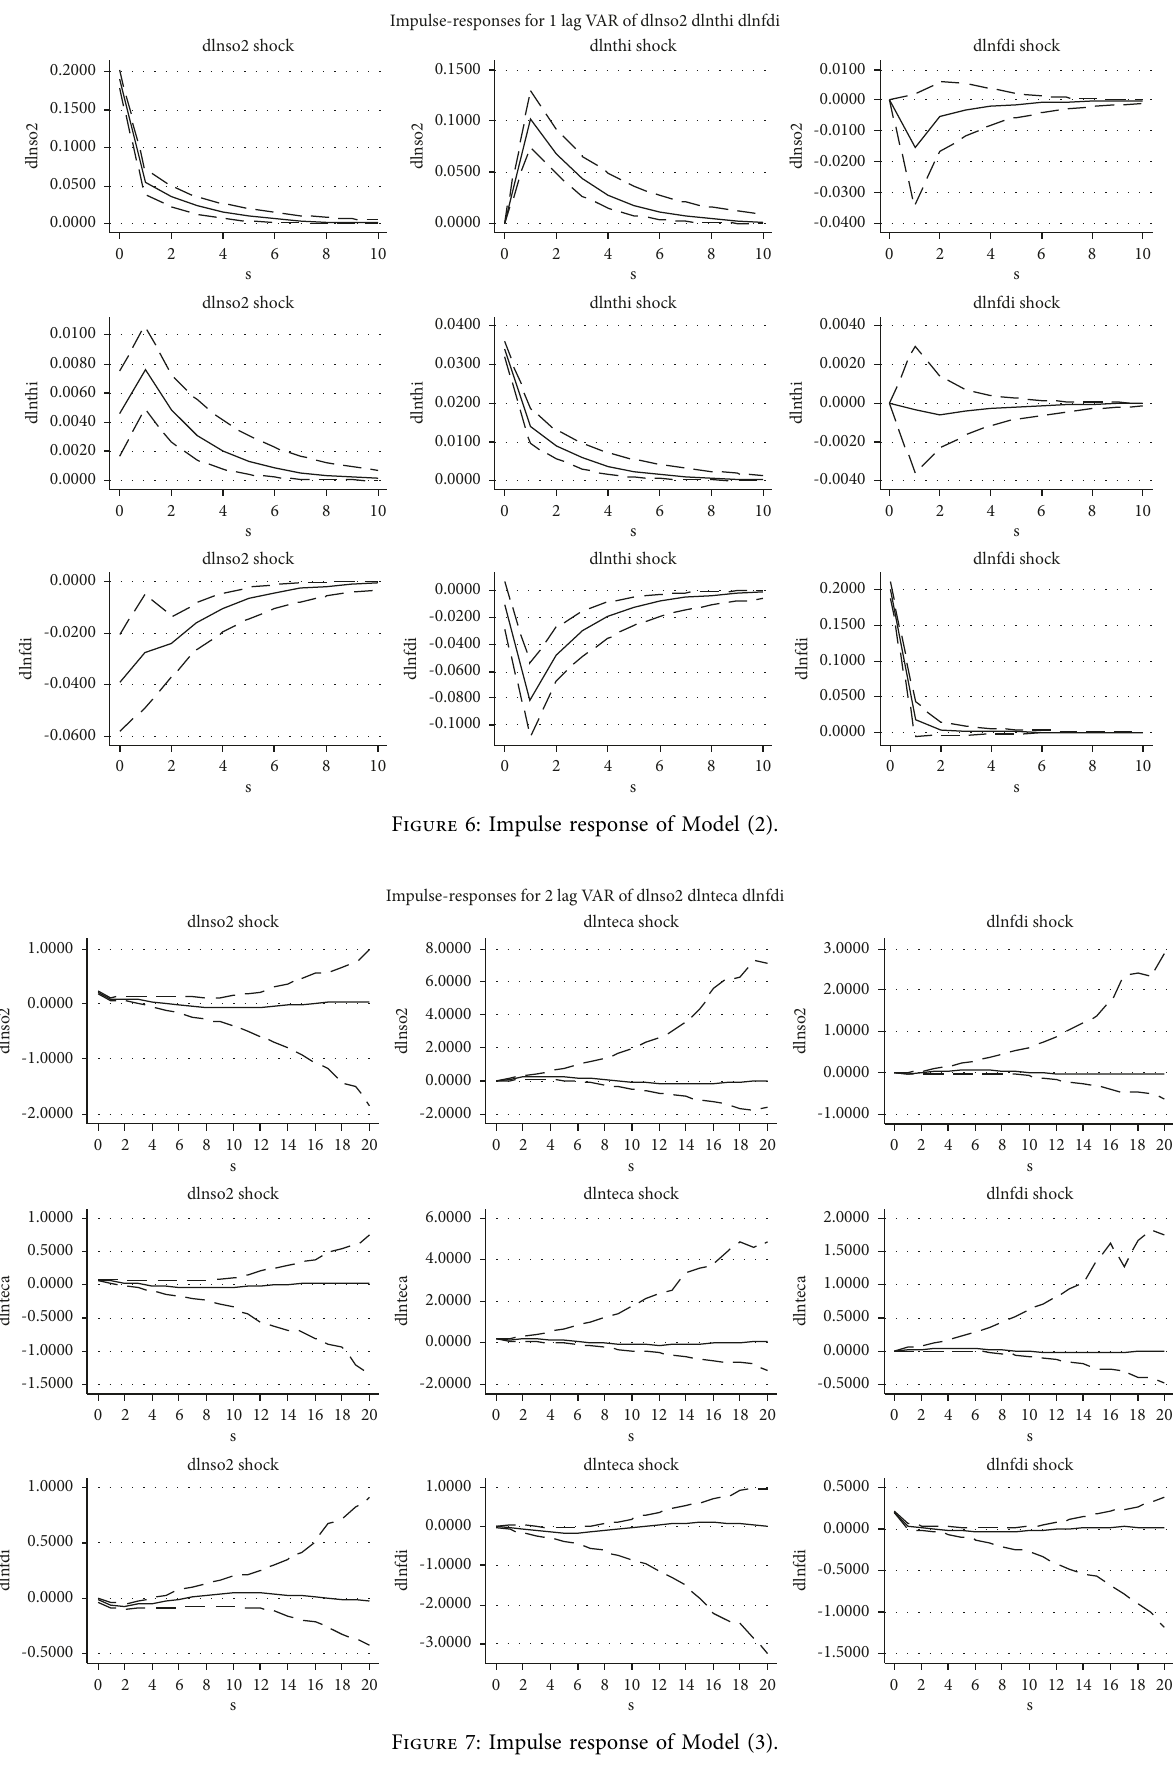
Figure 6: Impulse response of Model